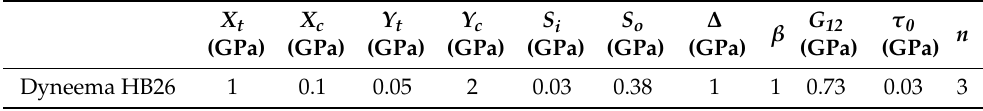
Table 3. The model’s 7 strength parameters and 4 Ramberg–Osgood (RO) fit